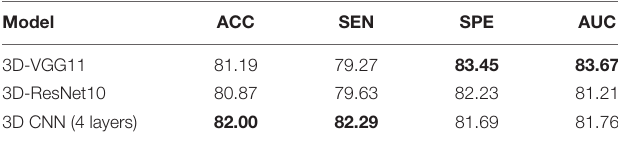
Bold values mean the best value in the comparative experiment.